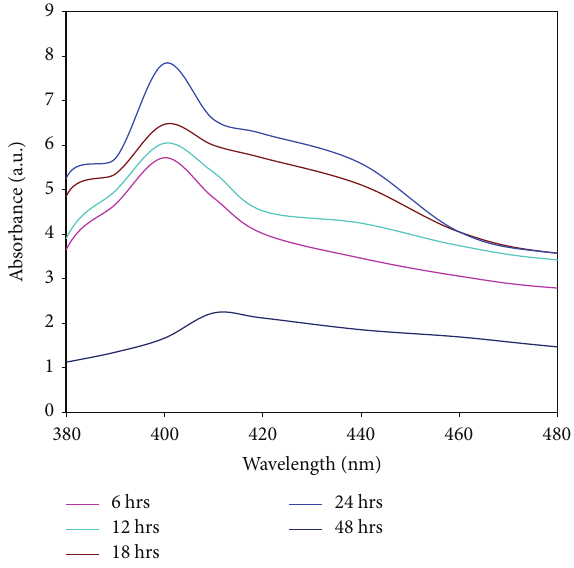
Figure 2: UV spectra of extracellularly synthesized silver nanopar- ticles using culture supernatant of Planomicrobium sp. show that the SPR band at 400 nm indicates nanoparticles